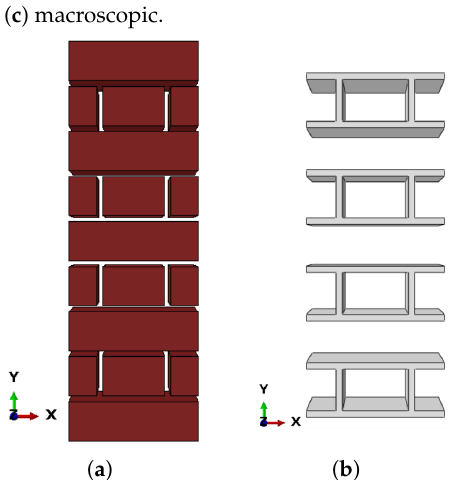
Figure 3. Numerical modelling methods of masonry walls: ( a ) microscopic; ( b ) simplified microscopic;